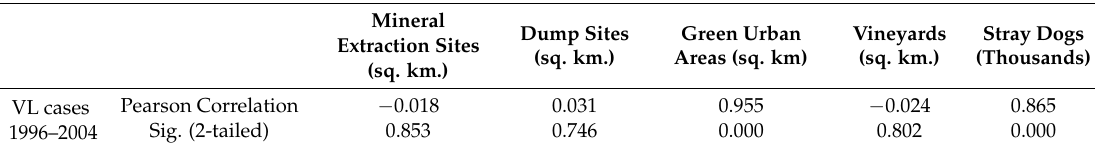
Table 2. Correlations (land cover and stray dogs).